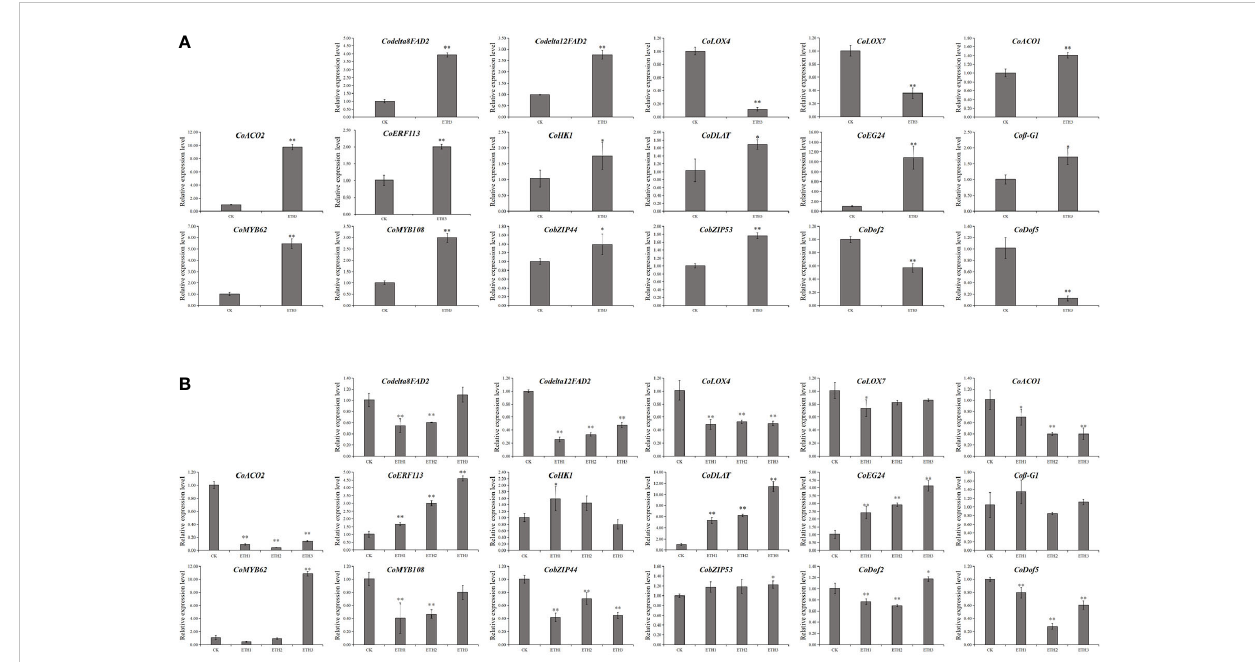
FIGURE 4 Expression of 17 DEGs identi fi ed to LA and ALA accumulation by qRT-PCR analyses from the ethephom treatment. (A) Expression levels of DEGs in shells of the control and ETH3 in 2020; (B) Expression levels of DEGs in seeds with three ethephon treatments (ETH1, ETH2, and ETH3), and the control in 2020. The control, ETH1, ETH2, and ETH3 represent 0, 0.5, 1.0, and 1.5 g L -1 ethephon, respectively. Single and double asterisks indicate differences at P < 0.05 and P < 0.01,